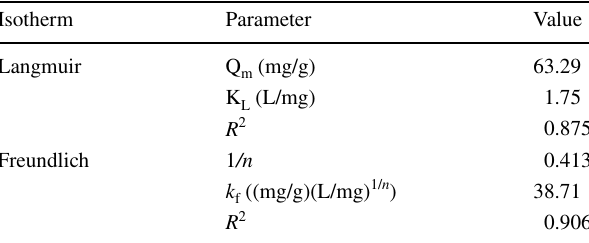
Table 7 Result of AG 20 adsorption isotherm onto HDTMA-Sep Isotherm